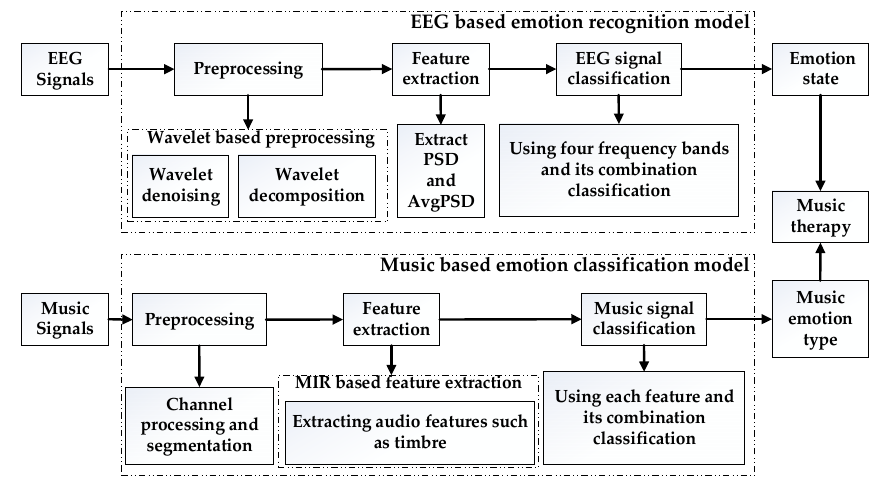
Figure 1. General architecture of music therapy calculation model.